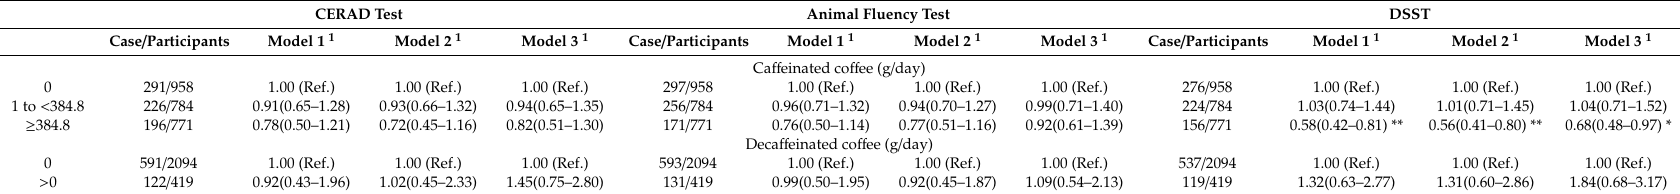
Table 3. Weighted odds ratios (95% confidence intervals) for scores on the Consortium to Establish a Registry for Alzheimer’s Disease (CERAD) test, Animal